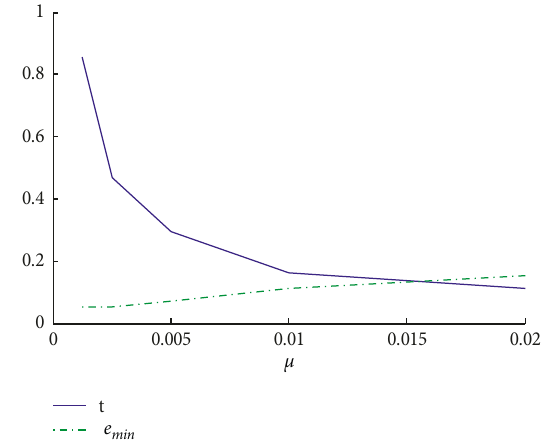
Figure 3: Curve of convergence time and steady-state error changing with. μ